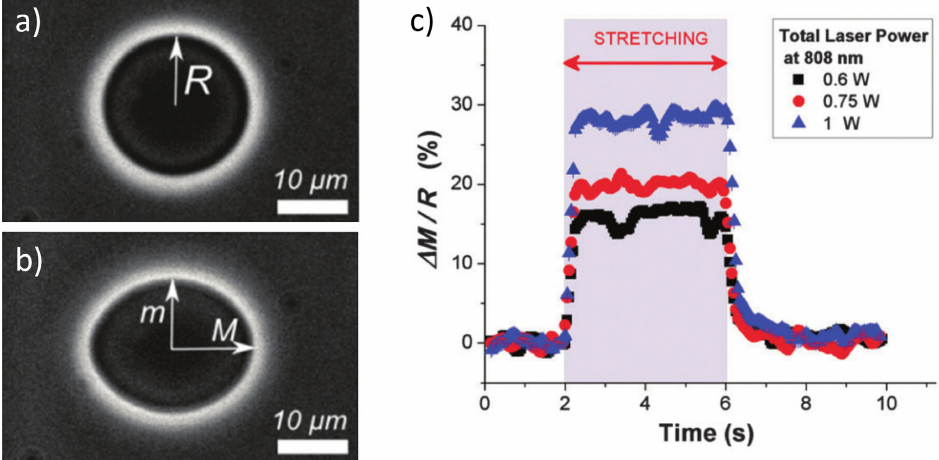
Figure 13. Optical stretching of vesicles. Microscope image of a vesicle trapped at low power ( a ) and deformed at high power ( b ); ( c ) The major axis strain of vesicles under 4 s stretching at various total powers. Figure reproduced from Reference [62] with permission from Royal Society of Chemistry.